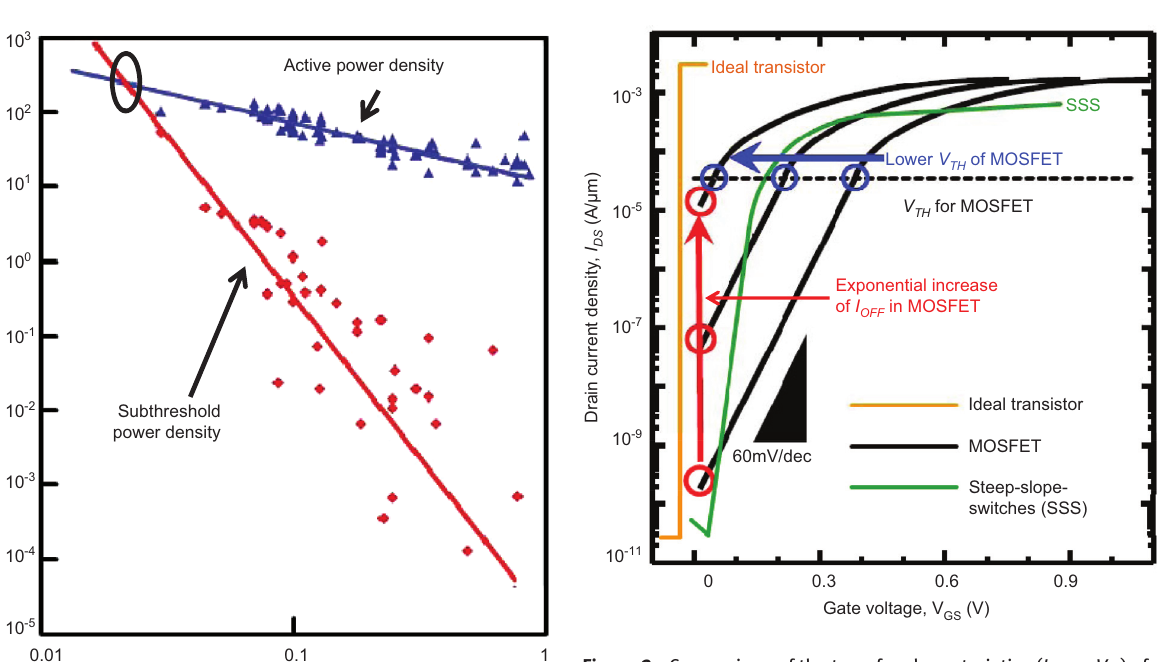
vs. V ) of Figure 2 Comparison of the transfer characteristics ( I DS GS ideal transistors (orange line), MOSFETs (black lines), and steep slope switches (SSS, green line). Owing to the incompressible 60 mV/dec SS at 300 K for MOSFETs, I of MOSFETs shows exponen- OFF tial increase with the scaling of V TH